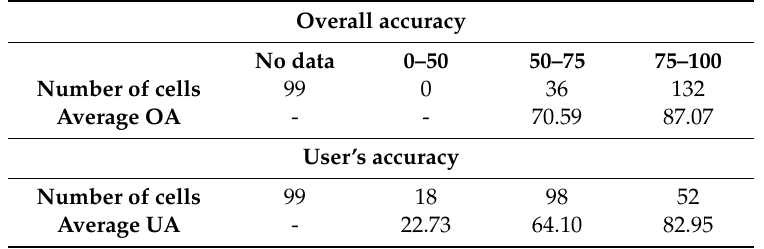
Table 3. Summary of overall accuracy and crop class user’s accuracy at grid level.